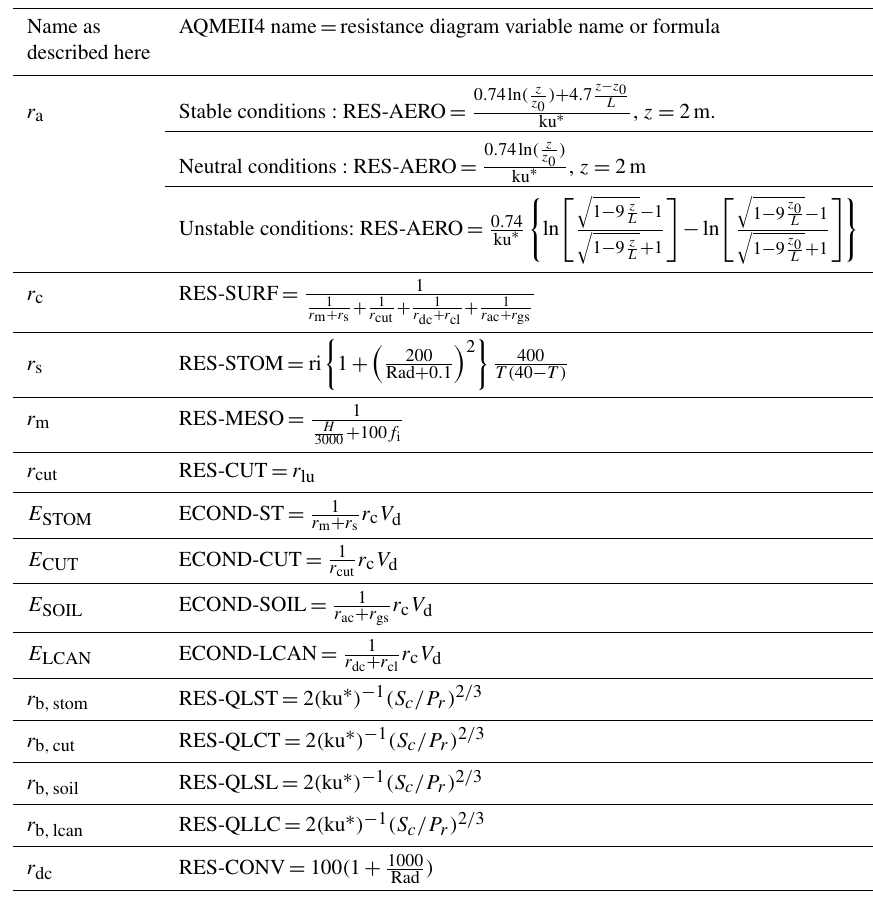
Prescribed values (table data) [pollutant, season]. r cl : for exposed surfaces in the lower canopy SO 2 , O 3 . r ac : for transfer that depends on canopy height and density. r gs : for ground surfaces SO 2 , O 3 . r si : for stomatal resistance. r lu : for outer surfaces in the upper canopy. H : Henry’s law constant. f i : reactivity